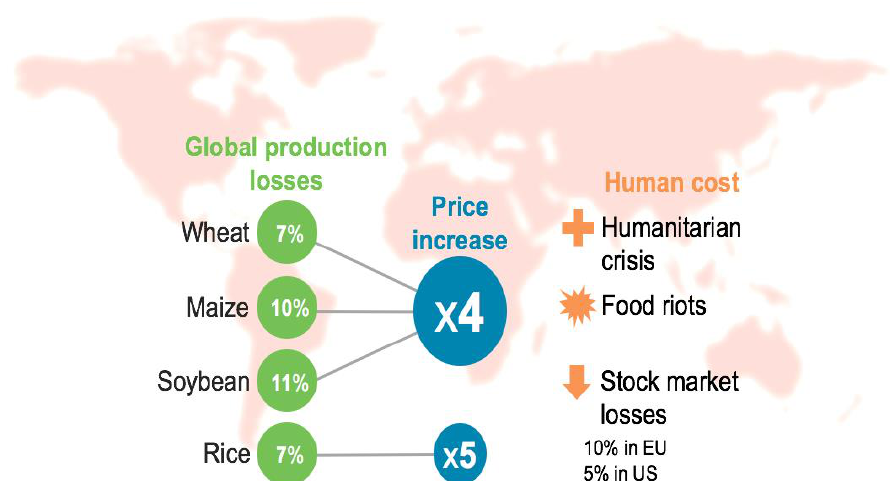
Figure 10. Supply chain and societal impacts of a plausible food systems shock. The Lloyd’s study [363] found that the impact of such a weather event would be serious and widespread. Adapted from Lloyd’s report with the permission from the authors.